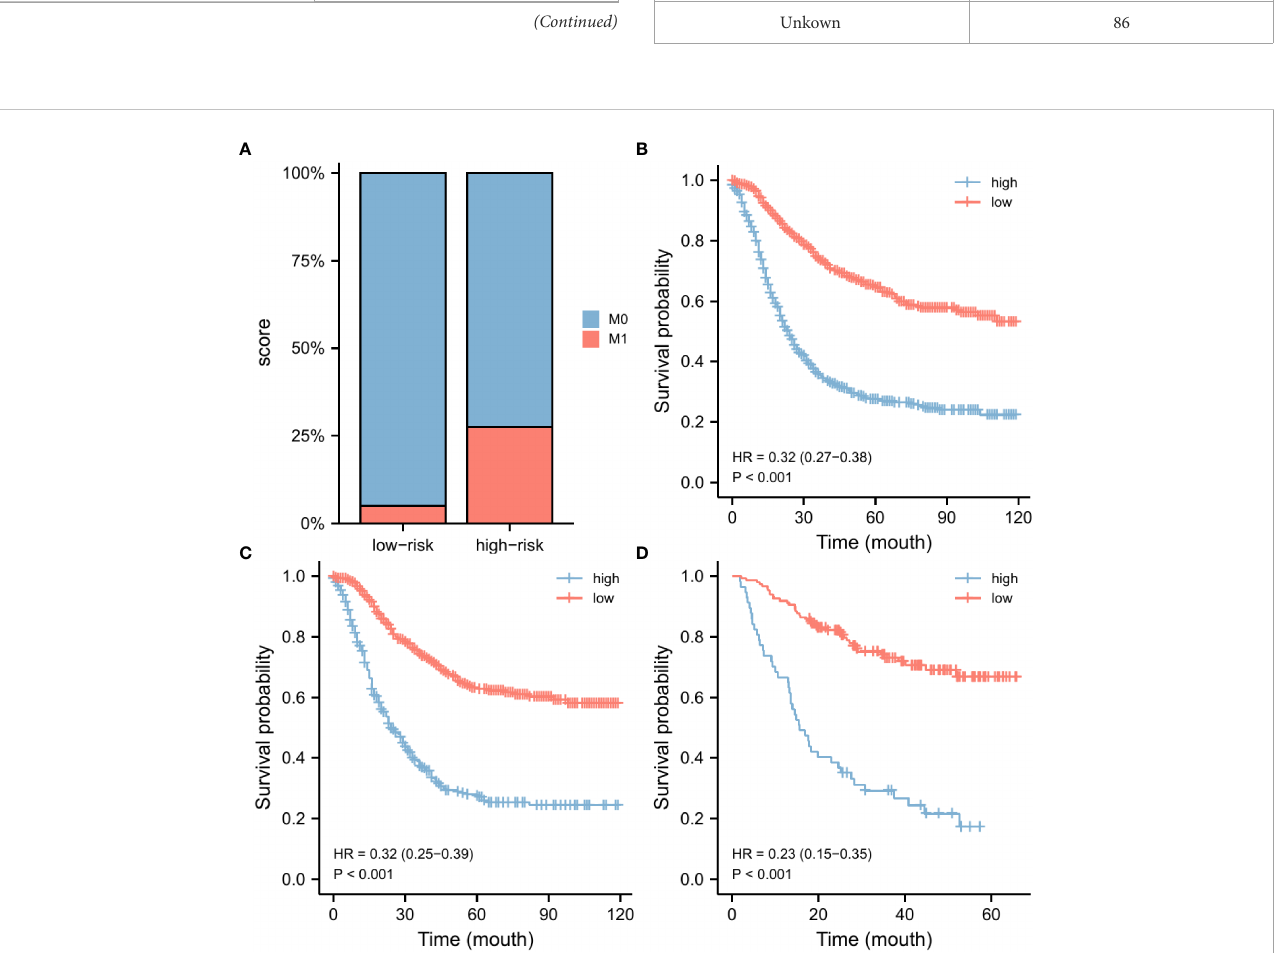
FIGURE 6 Nomogram risk score clinical application. According to the median risk score, our nomogram divides GC patients into two subgroups. There were various numbers of distant metastases in each subgroup (A) . The OS was evaluated in the training set (B) , the testing set (C) , and the external validation set (D) . GC, gastric cancer; OS, overall